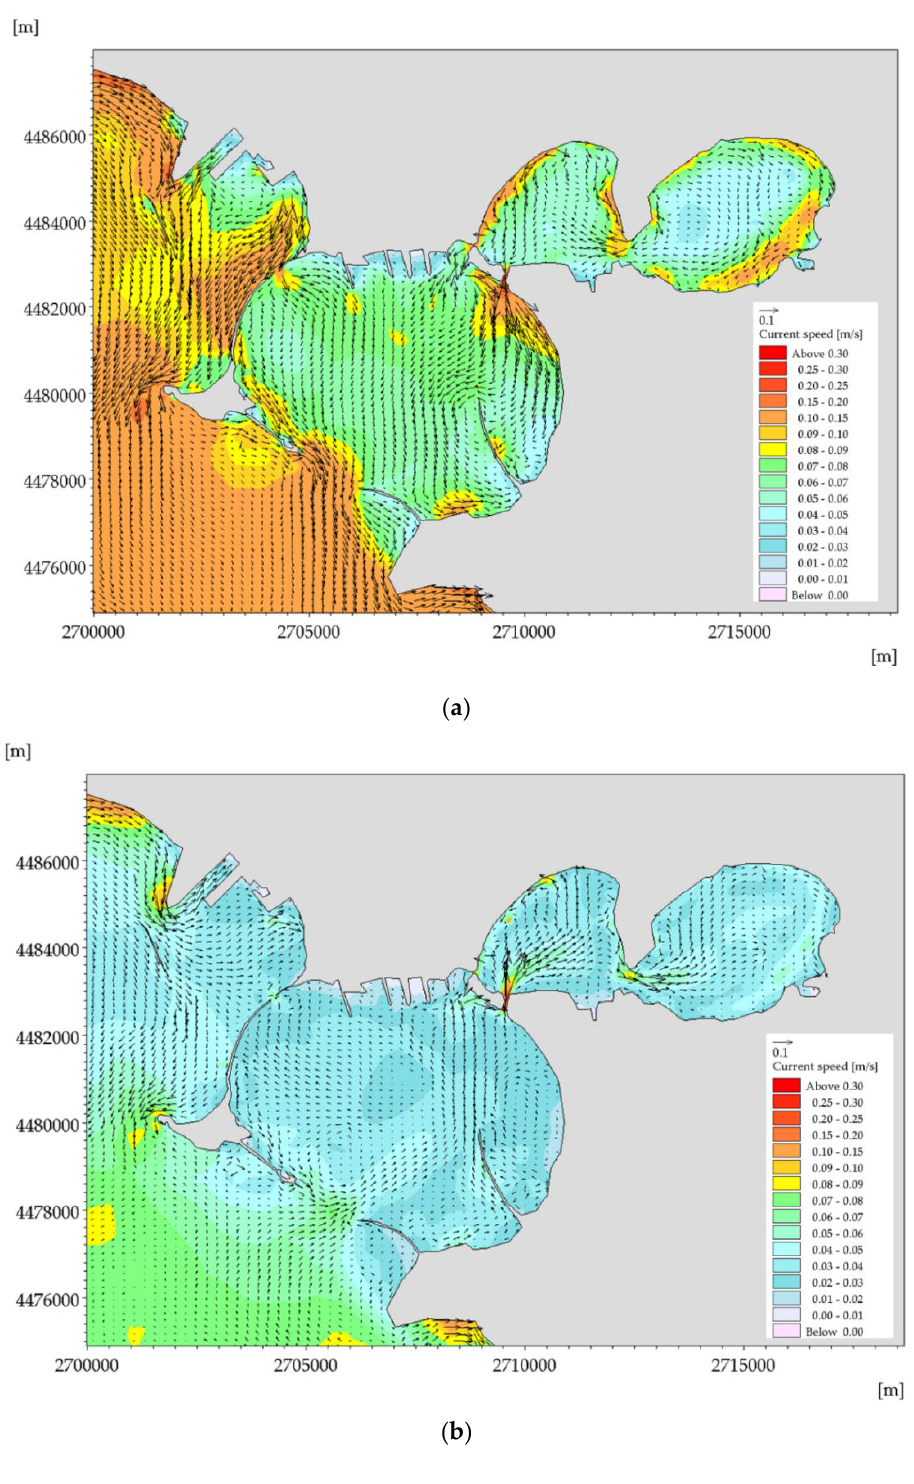
Figure 7. Computational maps of the annual-averaged currents ( a ) at the surface and ( b ) at the bot- tom.